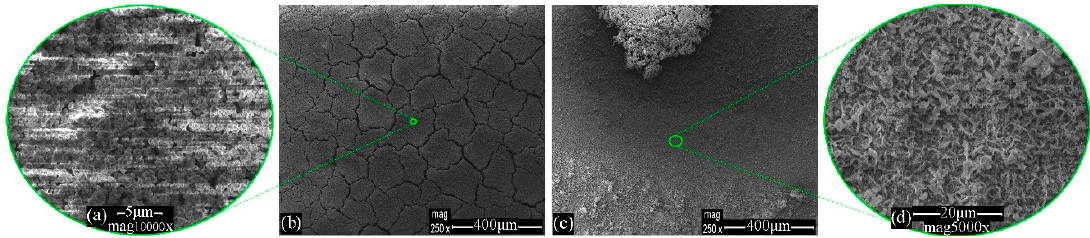
Figure 8. SEM images of mild steel immersed in 3.5 wt % NaCl for 96 h in the presence of Na 2 HPO 4 .